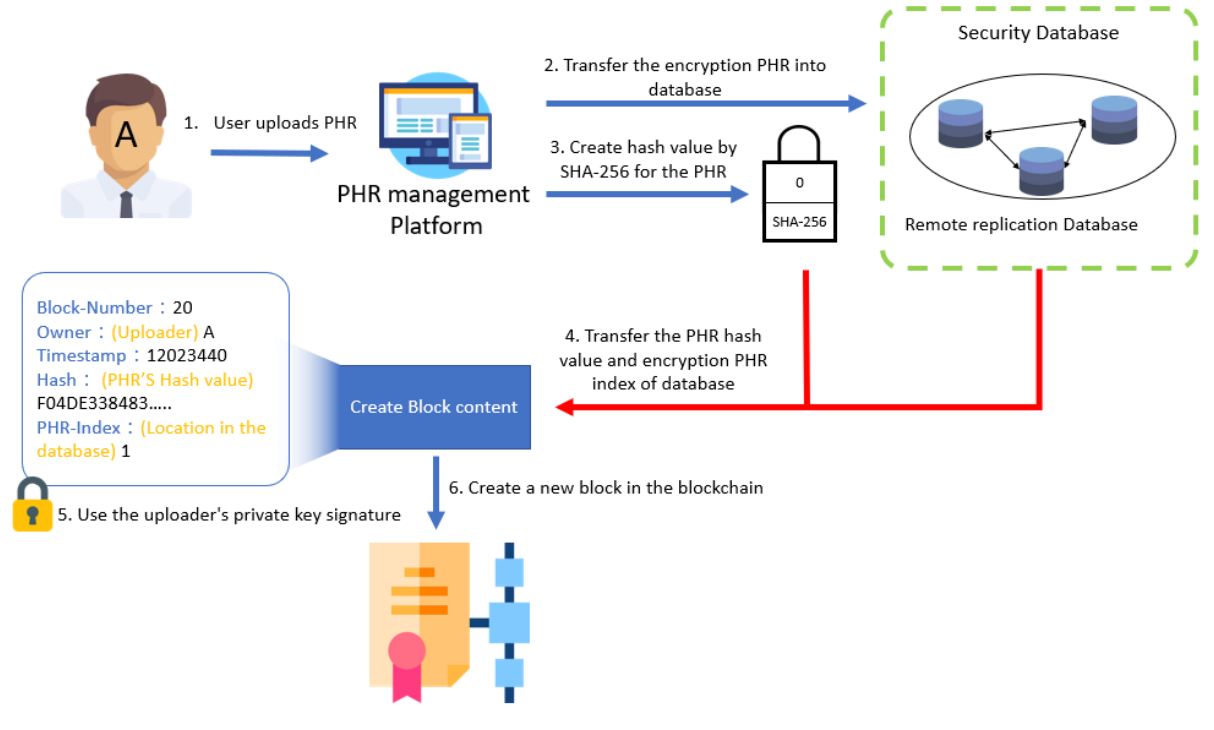
Figure 5. Workflow of a user uploading their personal health record. PHR: personal health